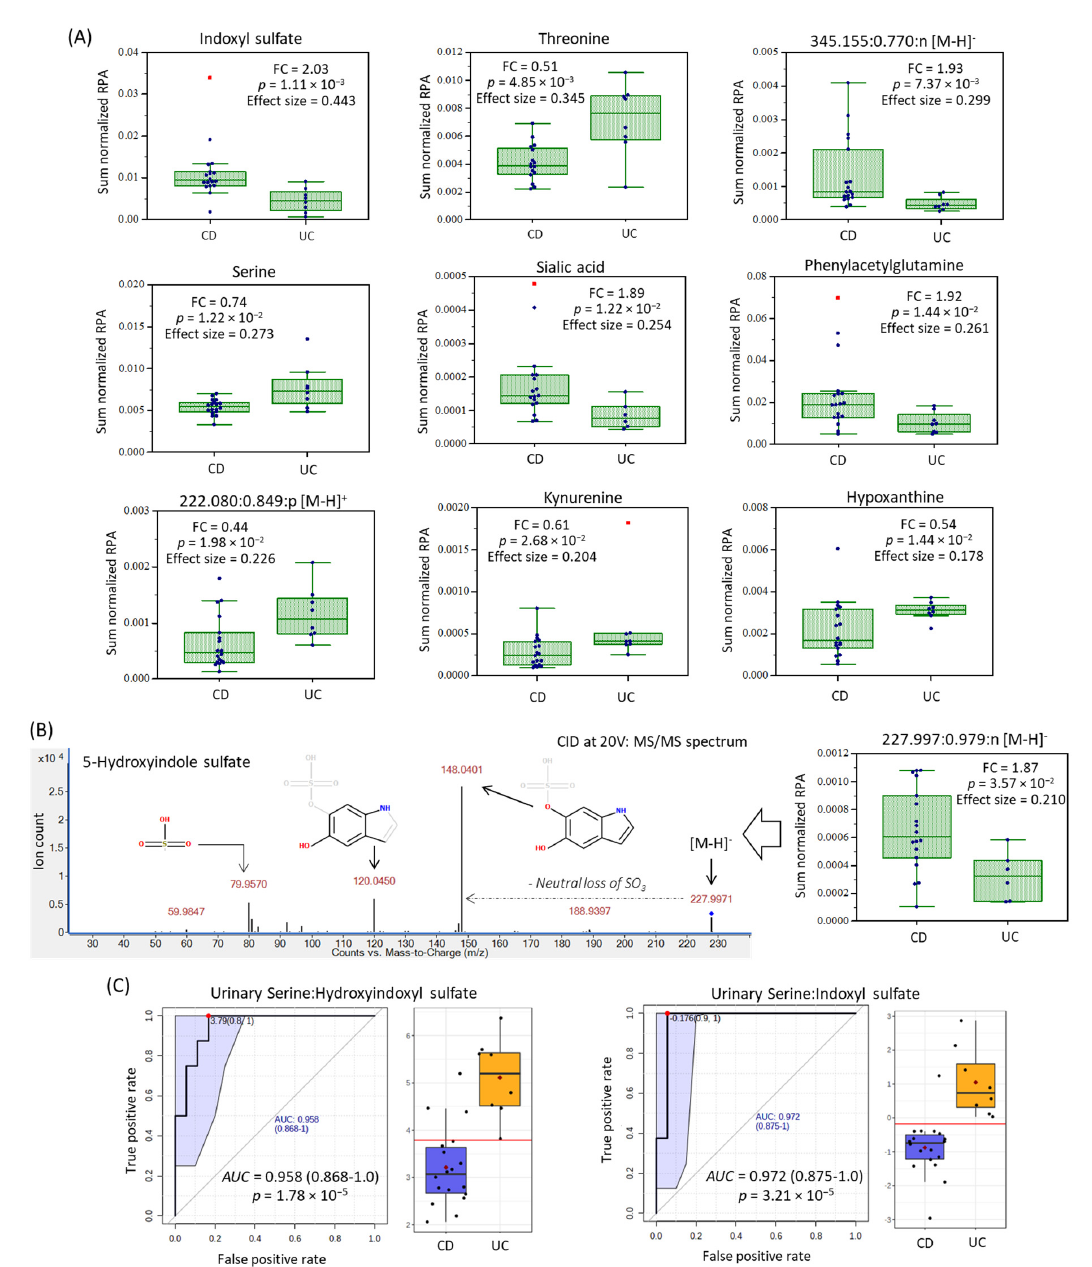
Figure 2. Top-ranked urinary metabolites that differentiate CD from UC pediatric patients ( p < 0.05) following sum (or osmolality) normalization when using a Mann–Whitney U -test. ( A ) Box-whisker plots for 10 urinary metabolites, including unknown metabolites annotated based on their characteristic accurate mass, relative migration time and ion detection mode ( m / z : RMT:mode) were subsequently identified by collision induced dissociation with MS/MS, as shown for ( B ) 5-hydroxy indoxyl sulfate. ( C ) Receiver operating characteristic (ROC) curves are depicted for two top-ranked ratiometric urinary biomarkers following glog transformation with good discrimination potential for the two major subtypes of pediatric IBD in affected children ( AUC > 0.960–0.970, p < 3.2 × 10 − 5 ).